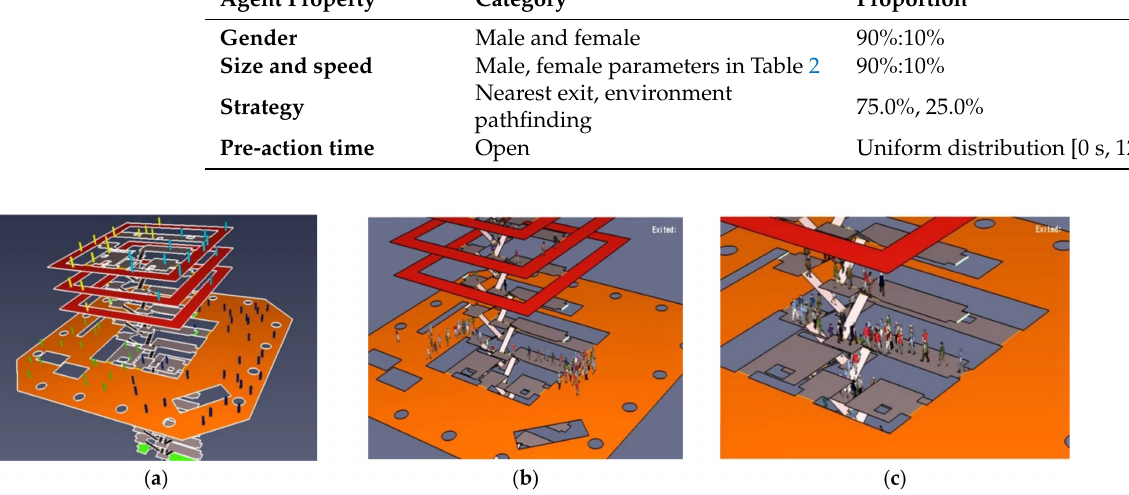
Figure 7. Evacuation process of constructors in Pathfinder. ( a ) distribution of constructor; ( b ) the arched pedestrian flow; ( c ) the last constructor enters into